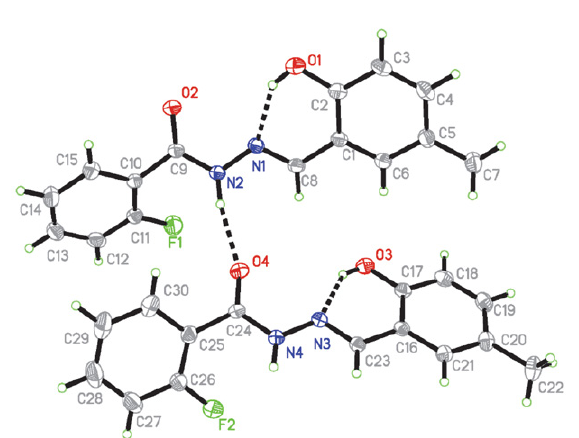
Figure 6. A perspective view of the molecular structure of 4 show- ing the atomic labeling scheme. The thermal ellipsoids are drawn at the 30% probability level. Hydrogen bonds are shown as dashed lines.